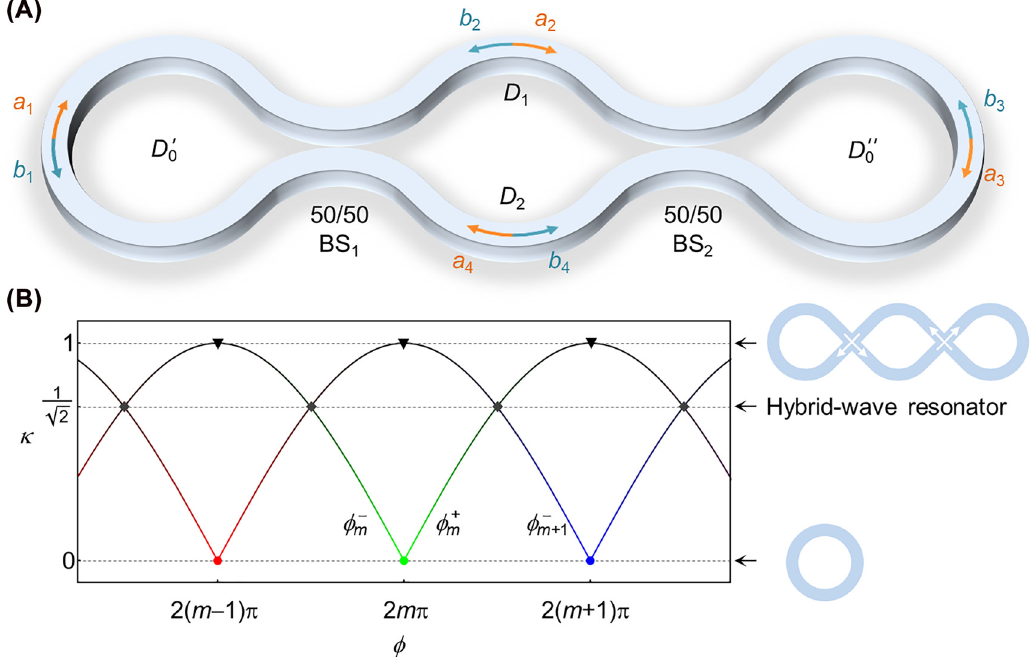
Figure 2: An implementation of a hybrid-wave resonator in integrated photonic platforms. (A) A hybrid-wave resonator can be constructed by deforming a ring resonator to introduce two 50/50 beam splitters, BS the union of the left and right side rings, and domains D amplitudes at each location and their traveling directions are indicated on the figure and labeled as a frequencies (horizontal axis) as a function of the beam splitter coupling coefficient 𝜅 (vertical axis). Note that each 𝜅 value represents an independent resonator structure. Horizontal dashed lines indicate values of 𝜅 for which the spectrum is doubly degenerate. The limit 𝜅 = 0 corresponds to conventional microring resonator with two degenerate traveling-wave modes in clockwise and counterclockwise direction while the limit 𝜅 = 1 corresponds to degenerate ‘‘knotted’’ modes. Hybrid-wave modes exist for 𝜅 = 1 ∕